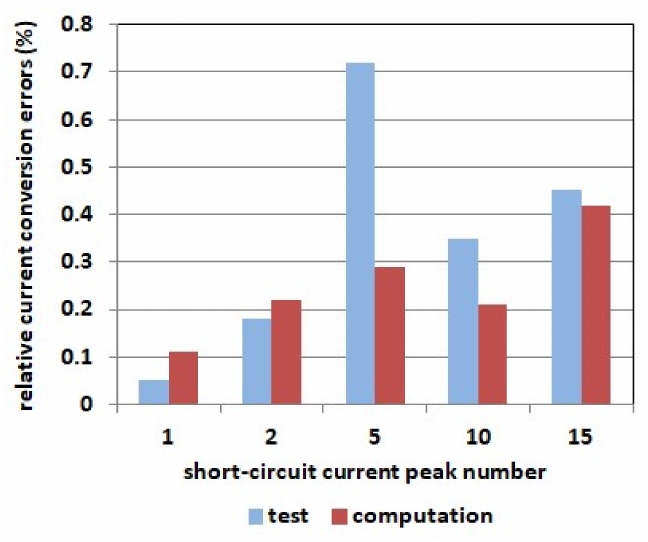
Figure 9. The percentage errors on the selected current peaks for the 50 kA/5 A short-circuit current transformer prototype based on the on the tested and calculated